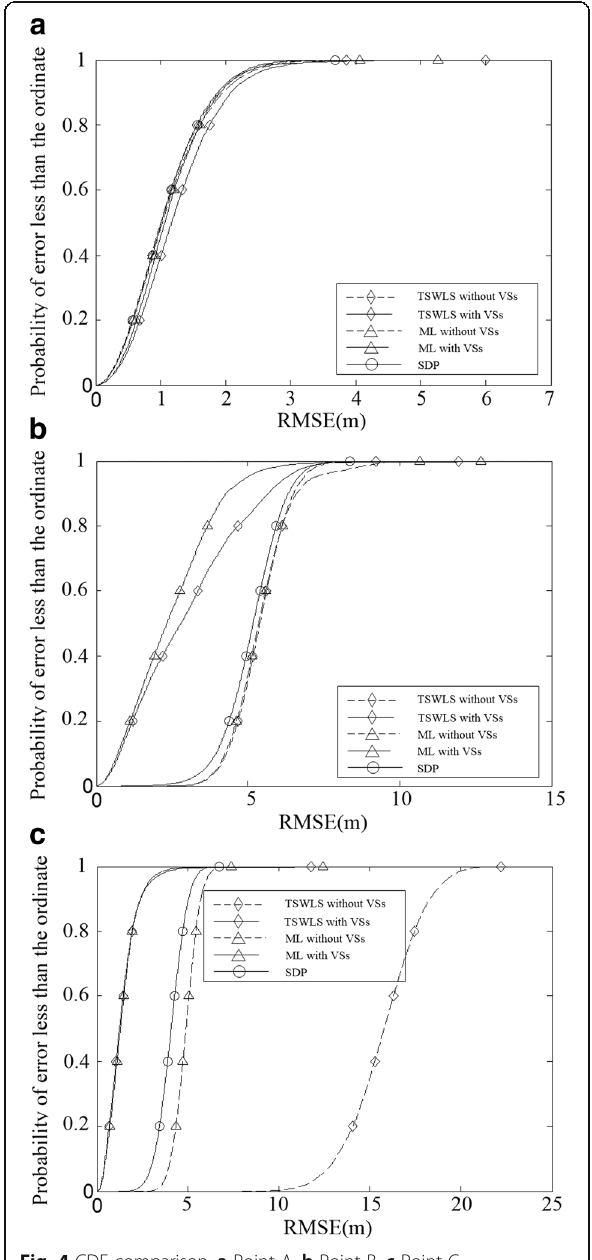
Fig. 4 CDF comparison. a Point A. b Point B. c Point